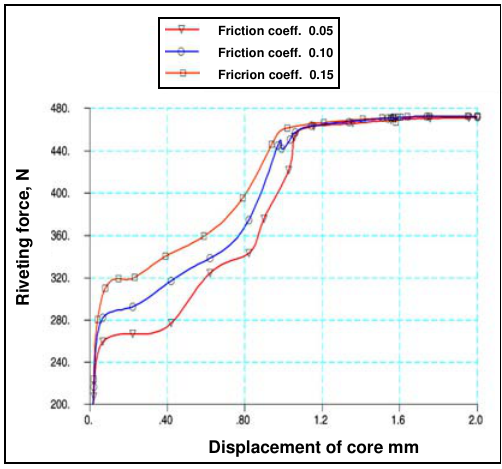
Fig 6. Plot of riveting forces in function of the rivet mandrel displacement for elastic-plastic material of mandrel (circular marks) and linear-elastic material of mandrel (square marks)